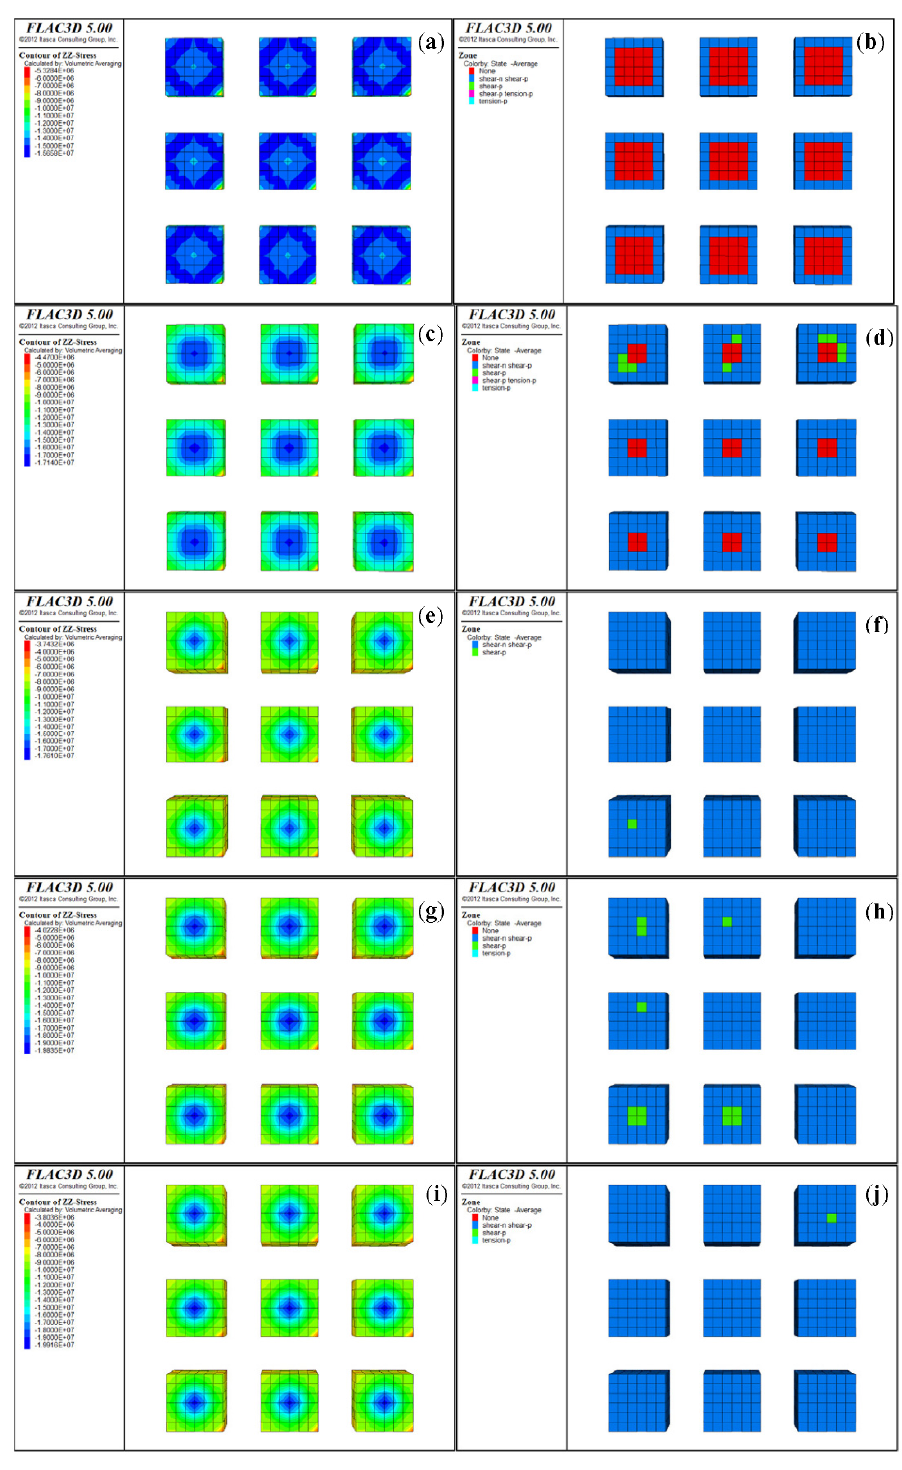
Figure 5. Distribution of the vertical stress and elastic zone with a mining width of 80 m and a variable mining thickness: ( a ) Vertical stress of 1 m thickness; ( b ) elastic zone of 1 m thickness; ( c ) vertical stress of 1.5 m thickness; ( d ) elastic zone of 1.5 m thickness; ( e ) vertical stress of 2 m thickness; ( f ) elastic zone of 2 m thickness; ( g ) vertical stress of 2.5 m thickness; ( h ) elastic zone of 2.5 m thickness; ( i ) vertical stress of 3 m thickness; ( j ) elastic zone of 3 m thickness.